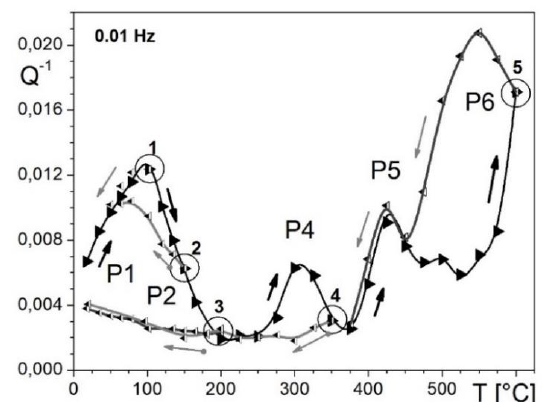
Figure 6. TDIF spectrum of Fe–13Al alloy as plotted from isothermal FDIF curves for f = 0.01 Hz. Arrows indicate whether FDIF tests were carried out with step-by-step increase or decrease in the test temperature [30].